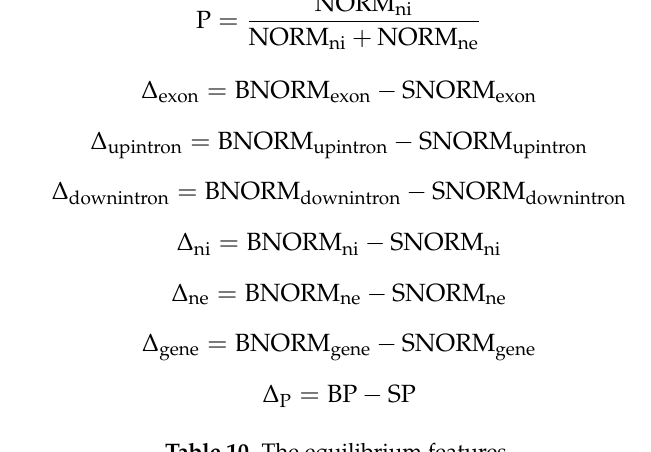
Table 10. The equilibrium